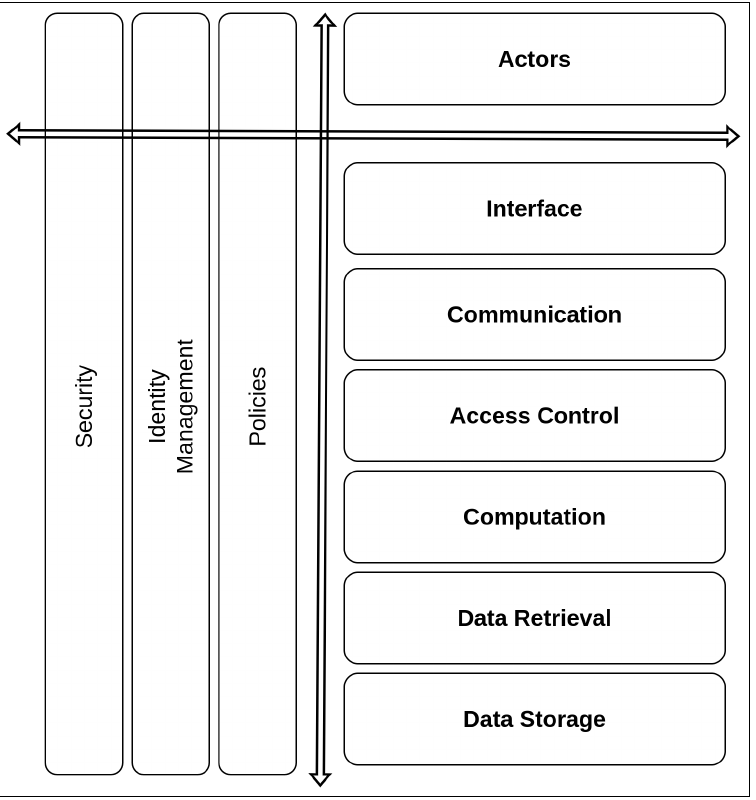
Figure 2. Representing Solid Pods as a collection of inter-related layers based on